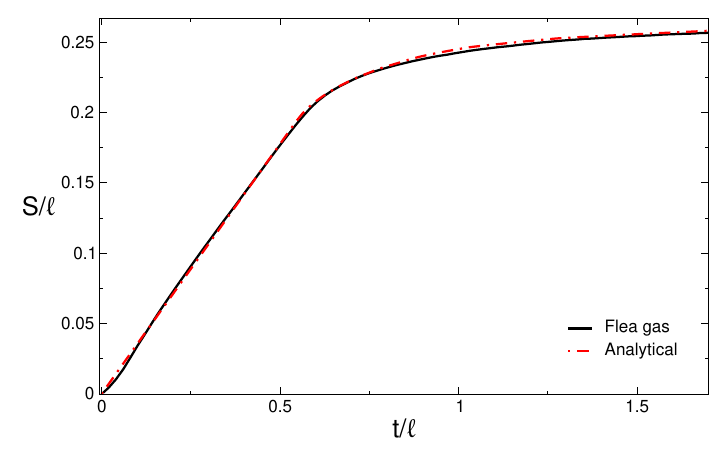
Figure 7: Dynamics of the von Neumann entanglement entropy after the quench from the Néel state in the XXZ chain with ∆ = 2. The entropy density S /(cid:96) is plotted versus the rescaled time t /(cid:96) , with (cid:96) the subsystem size. The continuous line corresponds to the flea gas simulation for a subsystem with (cid:96) = 100. The length of the chain is L = 2000. The results are averaged over ∼ 1000 realization of the dynamics. The dash-dotted line is the analytical result